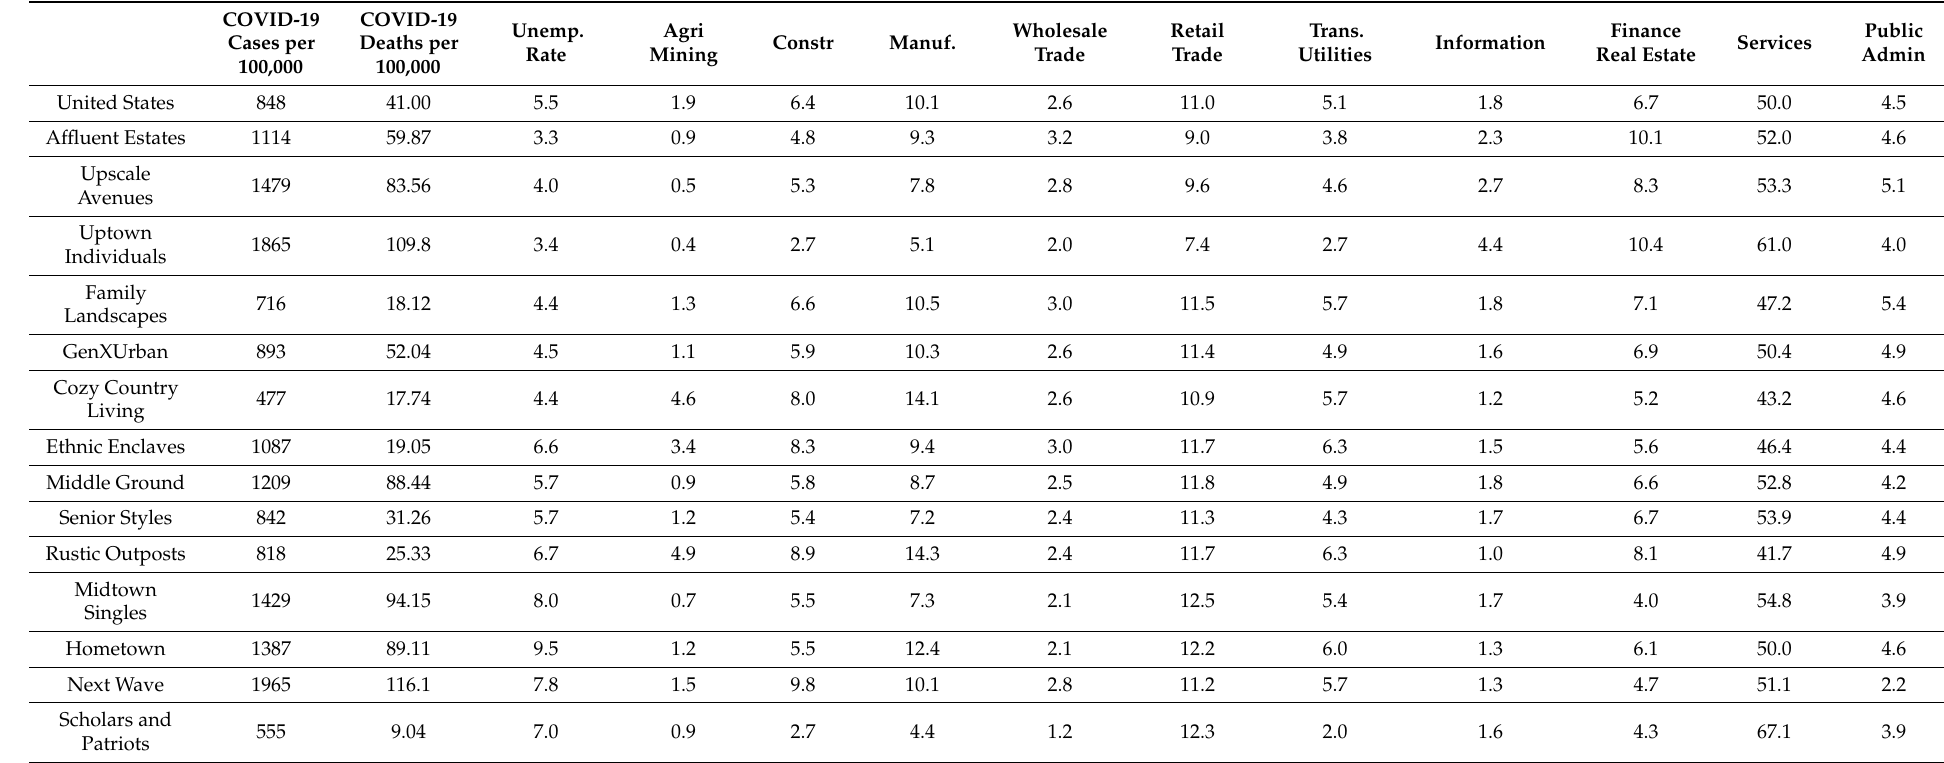
Table 7. Employment by Industry